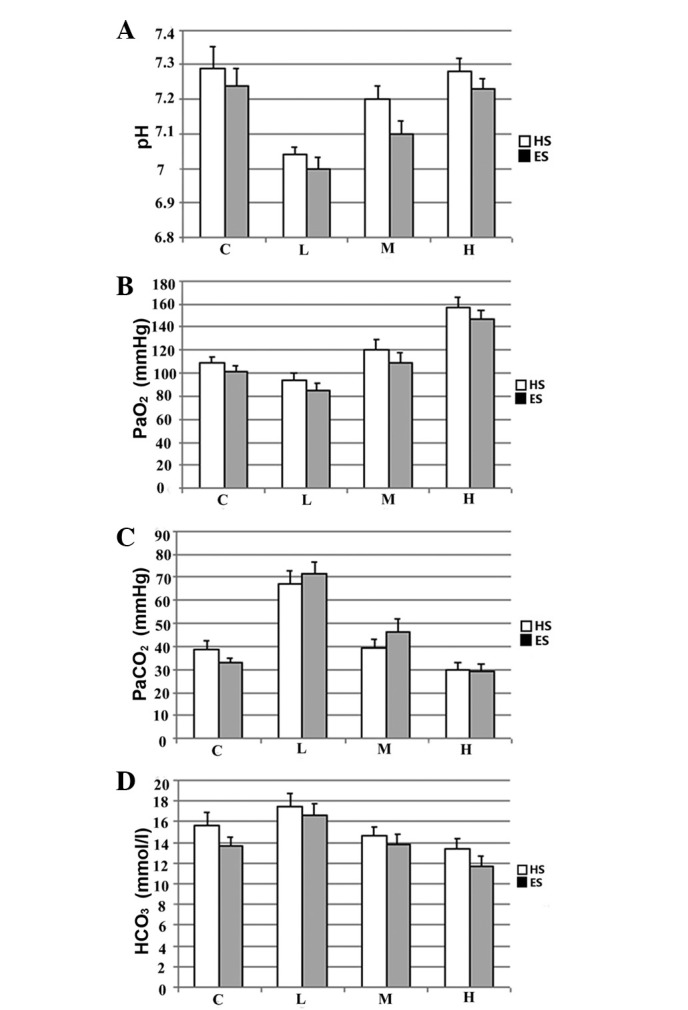
Blood gas. (A) pH; (B) PaO2 (mmHg); (C) PaCO2 (mmHg); (D) HCO3 (mmol/l). HS, hemorrhagic shock; ES, endotoxic shock; C, control; L, low Vt; Vt, tidal volume.